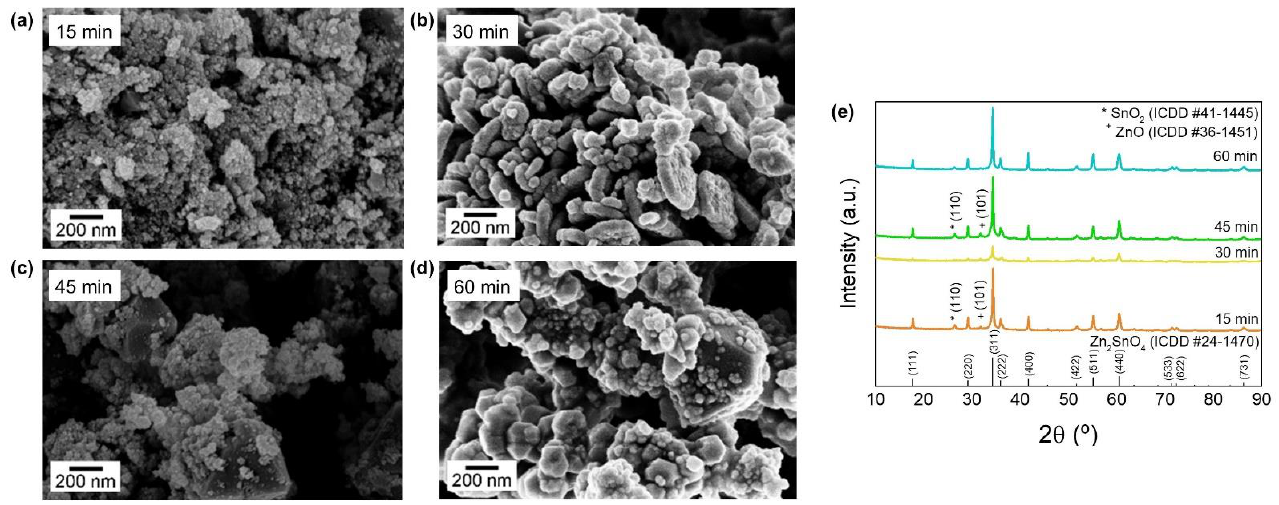
Figure 2. ( a – d ) SEM images and ( e ) XRD pattern of the synthesized ZTO nanostructures in the microwave system for 15, 30 (Zn 2 SnO 4 nanoplates), 45, and 60 min (Zn 2 SnO 4 polyhedrons).